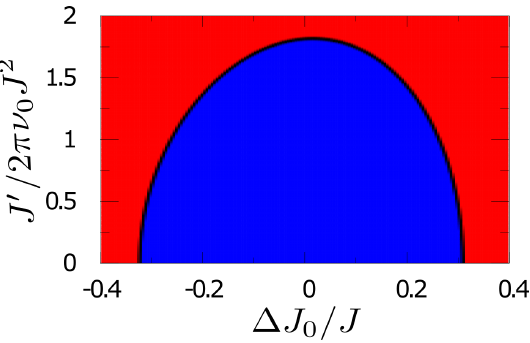
Figure 5: Phase diagram of the dissipative Hofstadter state as function of ∆ J shift in the onsite energy in Eq. (13), and of J (cid:48) , the amplitude of a parasitic hopping Hamiltonian in the master equation (1). The blue (red) regions correspond to non- = 1 ( C = 0), where the Chern number is defined trivial (trivial) Chern number C 1 1 in Eq. (19) below. The parameter values are the same as in Fig.